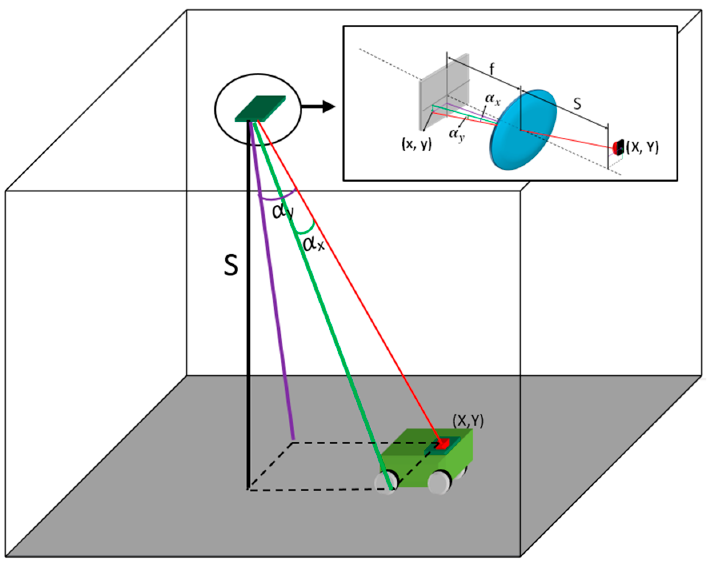
Figure 1. LPS System with a PSD sensor where f is the focal distance, S is the distance between emitter IR and Lent, (cid:2009) (cid:3051) y (cid:2009) (cid:3052) the angles of incidence for each axis, x , y the impact point over the PSD sensor and X , Y the point in the